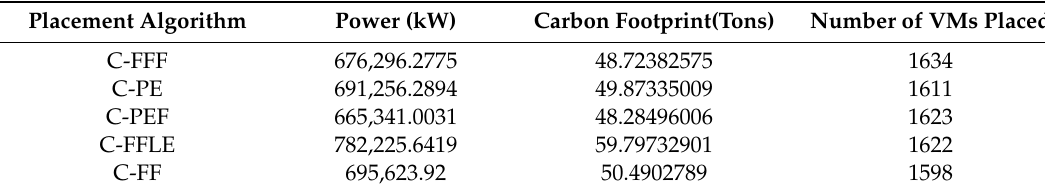
Table 7. Power and carbon footprint for di ff erent VM placement algorithms.